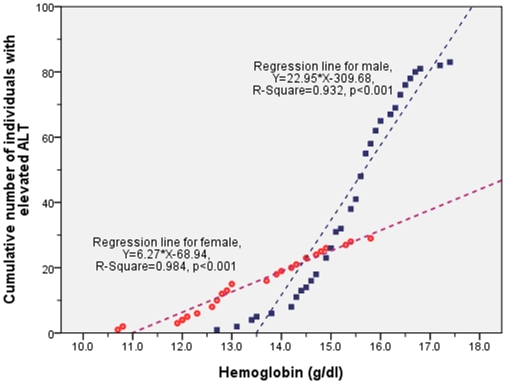
The cumulative number of individuals with abnormal ALT has a linear correlation with the hemoglobin levels for both genders, with both regression lines being statistically significant.The slope of the regression line is higher for males than for females: 22.95 vs. 6.27. According to the regression lines, the hemoglobin levels at which the cumulative number of abnormal ALT would be zero, are about 11.0 g/dl for females and 13.5 g/dl for males.